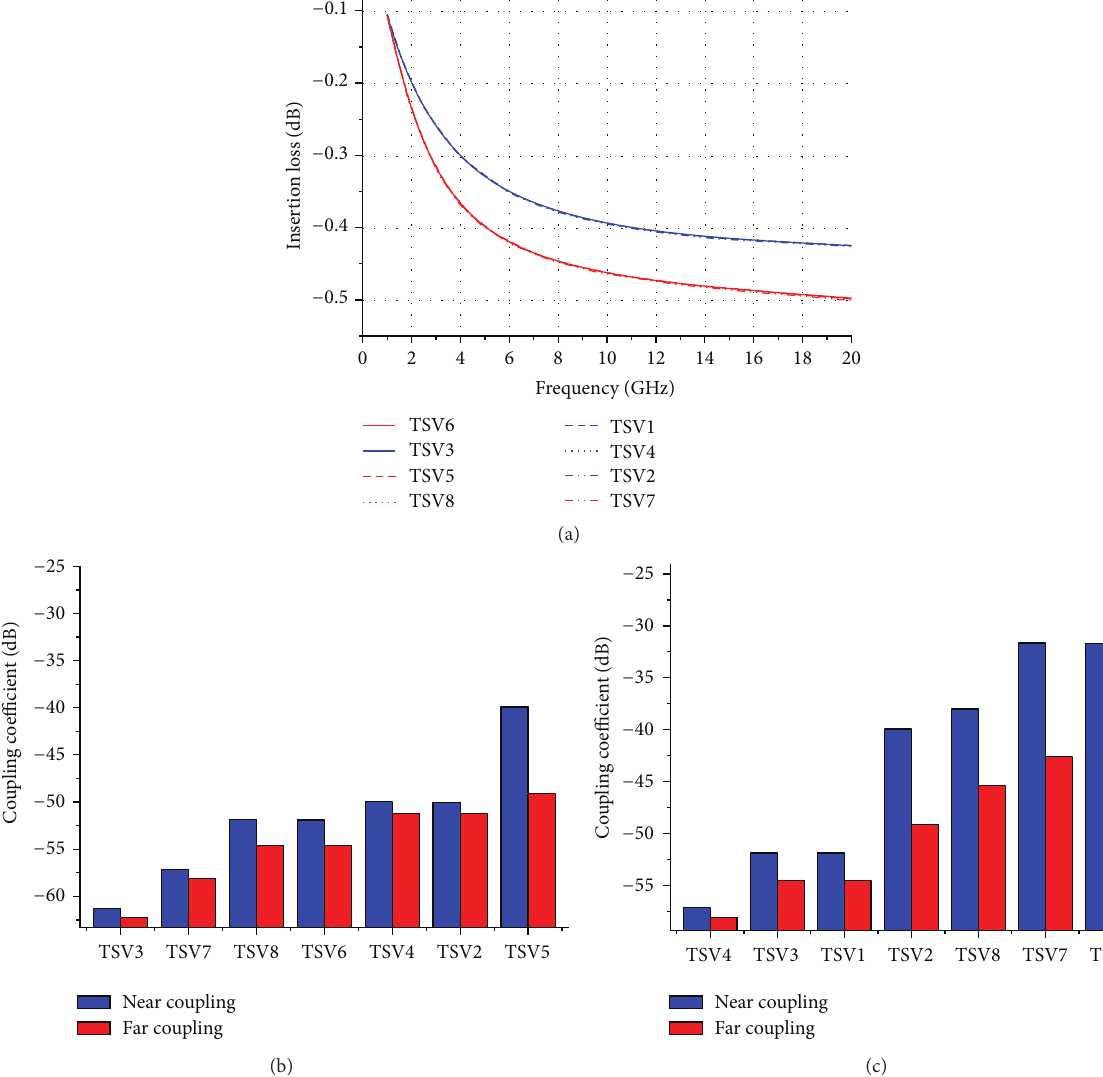
Figure 14: 𝑆 parameters result of Model 1. (a) Insertion loss of each TSV, (b) the cross talk from the aggressive TSV to TSV1 at 20GHz, and (c) the cross talk from the aggressive TSV to TSV6 at 20